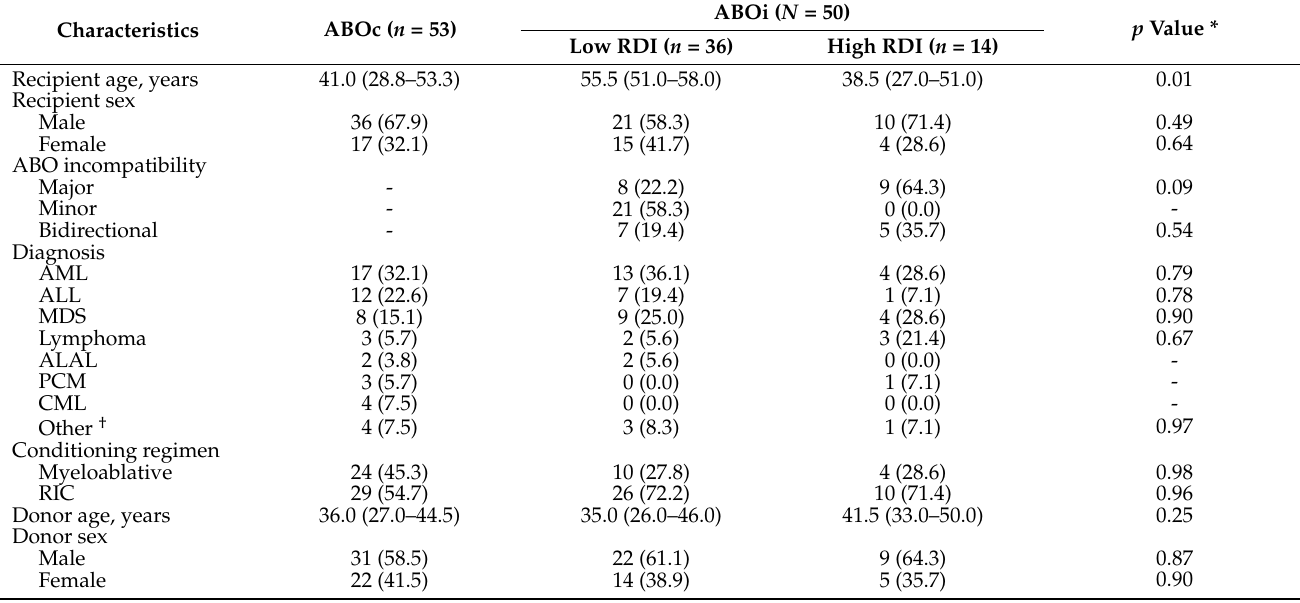
Table 1. Study population